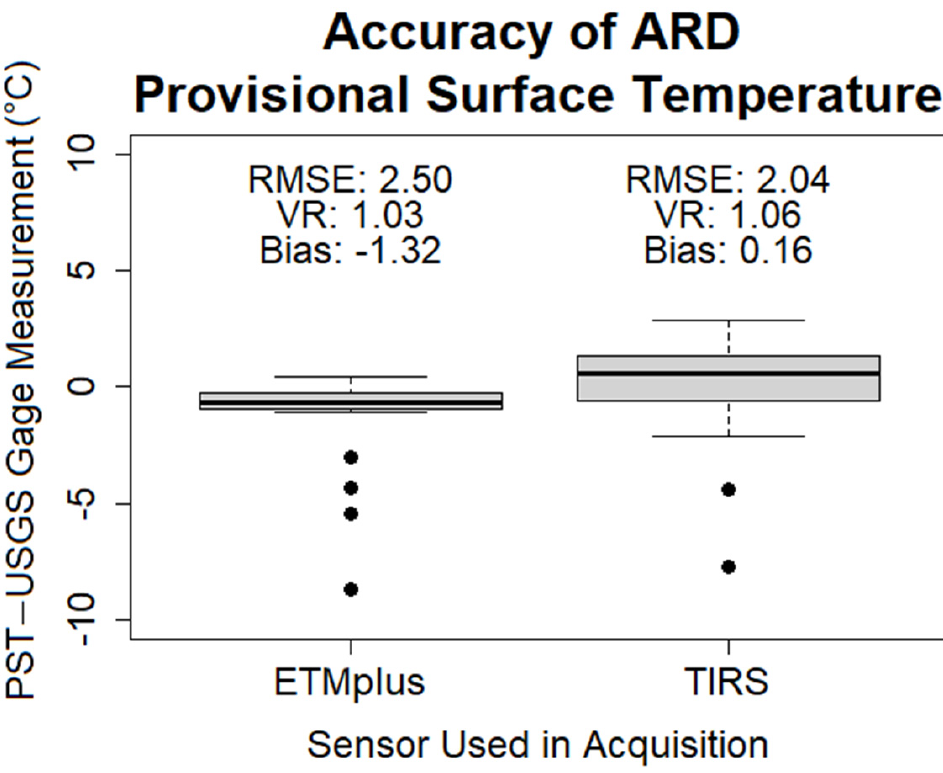
Figure 8. Boxplot depicting how the sensor used for acquiring the water temperature estimate influences the accuracy of estimated water temperature; Landsat 7 carries the Enhanced Thematic Mapper Plus (ETM+) while Landsat 8 carries the Thermal Infrared Sensor (TIRS).